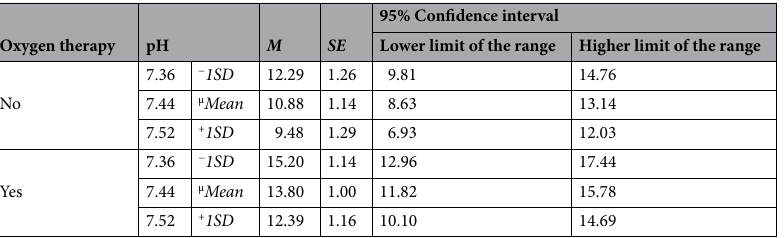
95% Confidence interval Lower limit of the range Higher limit of the